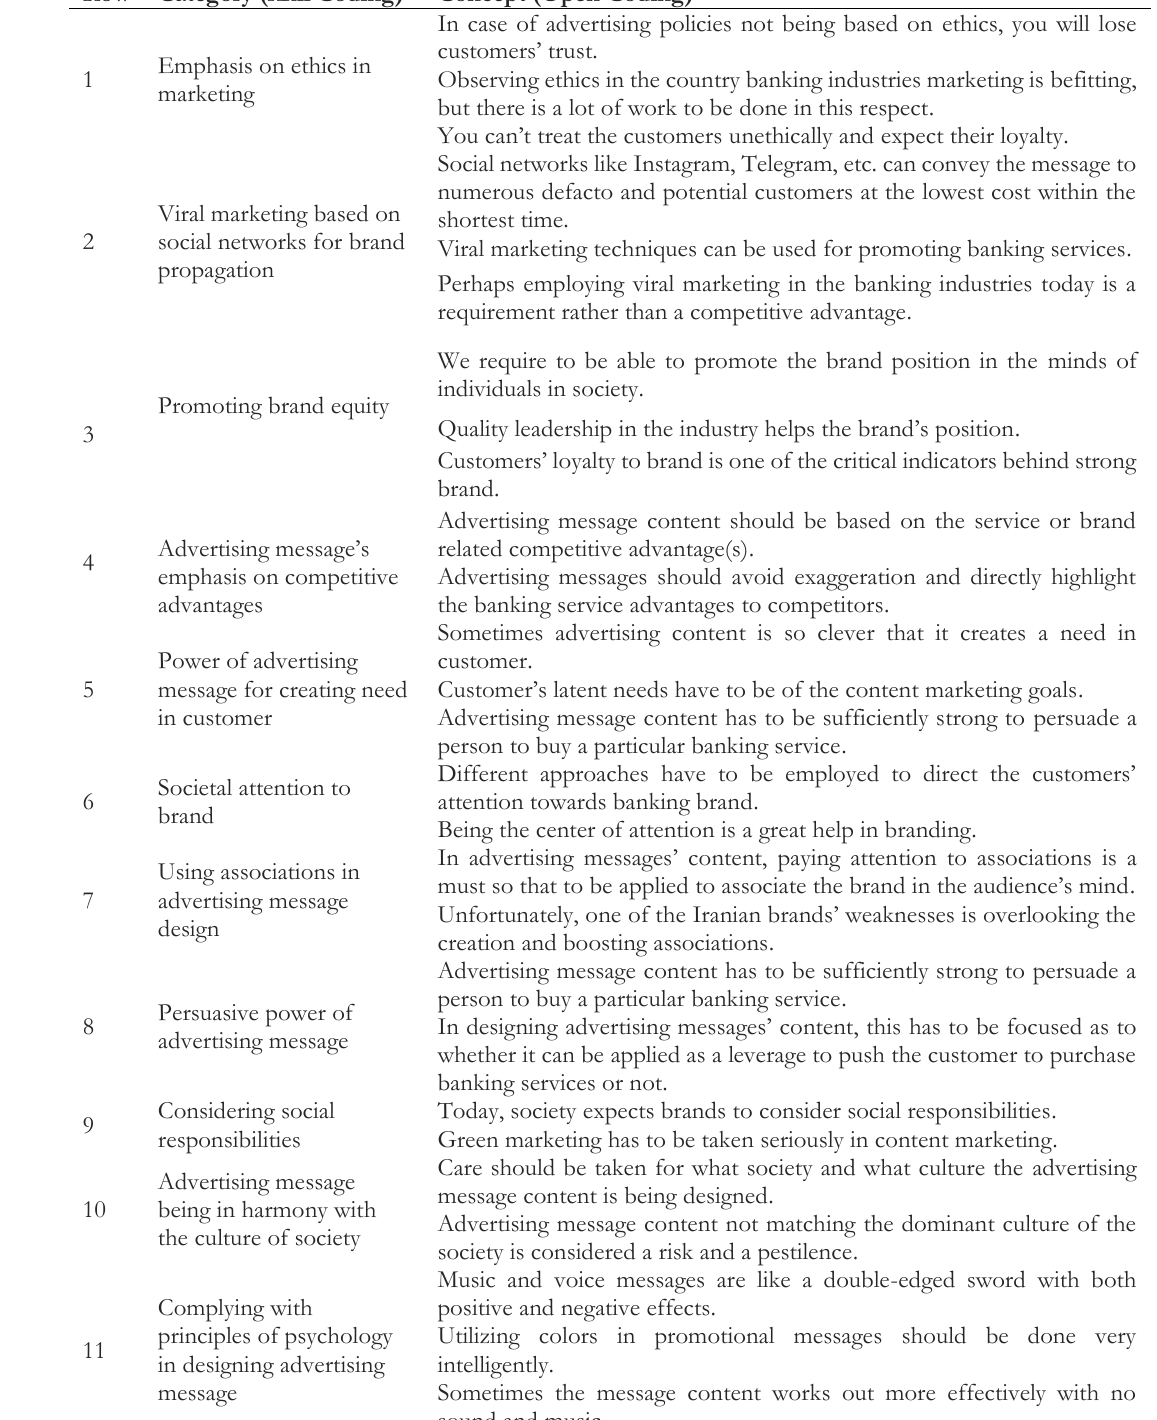
Table 3. Identified categories along with relevant